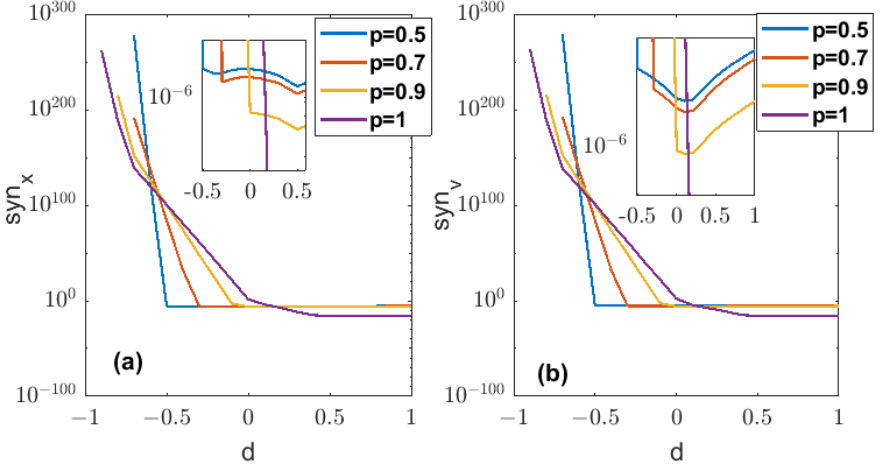
Figure 9. The average synchronization error 𝑆𝑦𝑛 𝑥 ( a ) and 𝑆𝑦𝑛 𝑣 ( b ) as functions of the velocity cou- pling strength 𝑑 with different orders 𝑝 = 0.5,0.7,0.9,1 .